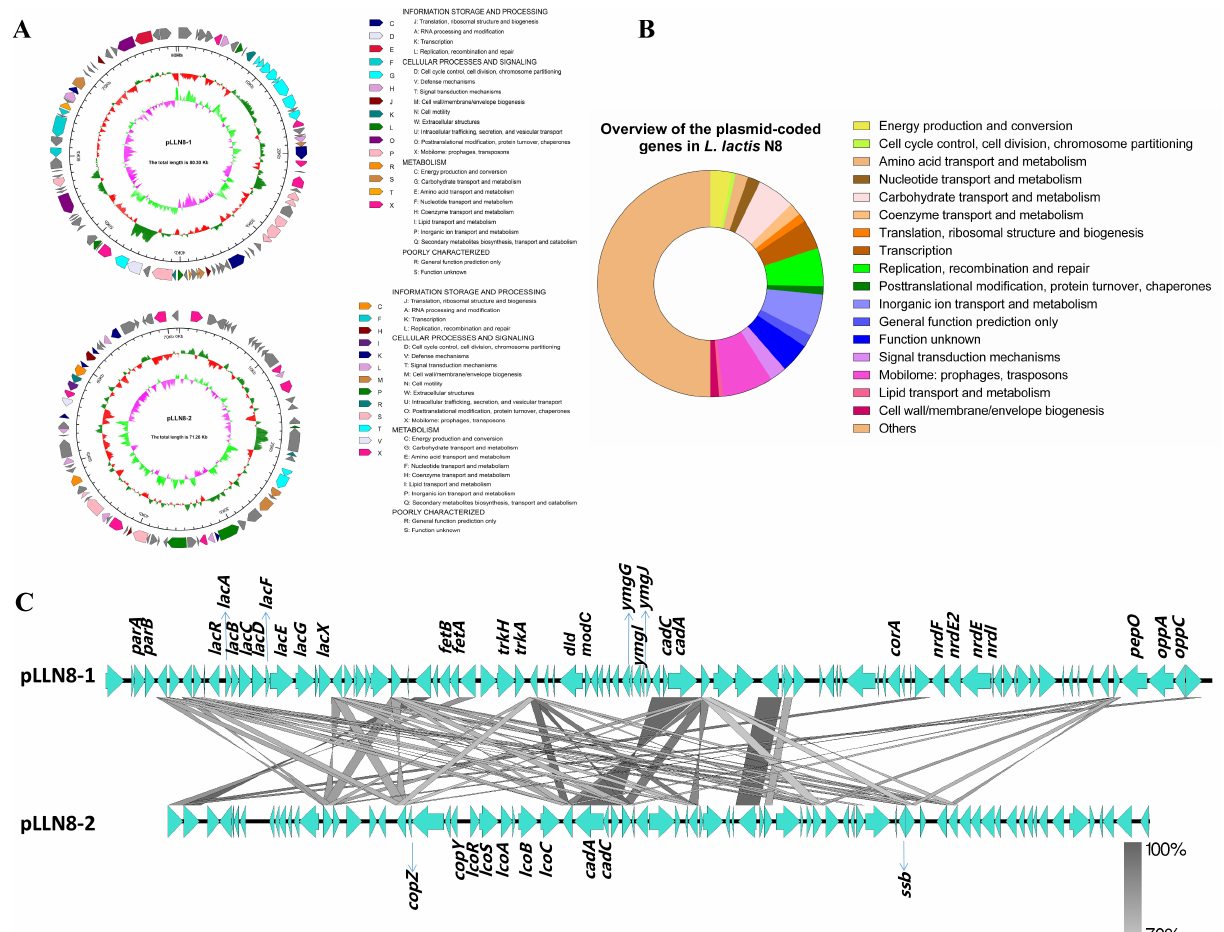
Figure 4. Plasmid genetic maps of L. lactis N8. ( A ) Arrows indicate positions, size and direction of predicted genes. Putative functions of genes are presented by colors. From outer to inner circle: gene function annotation results, genome GC content, genome GC skew. ( B ) Overview of the functions of plasmid-encoded genes in L. lactis N8. The sum of the sizes of the genes within a category relative to the total size of all plasmid genes was used. ( C ) Comparison of the homology of two large